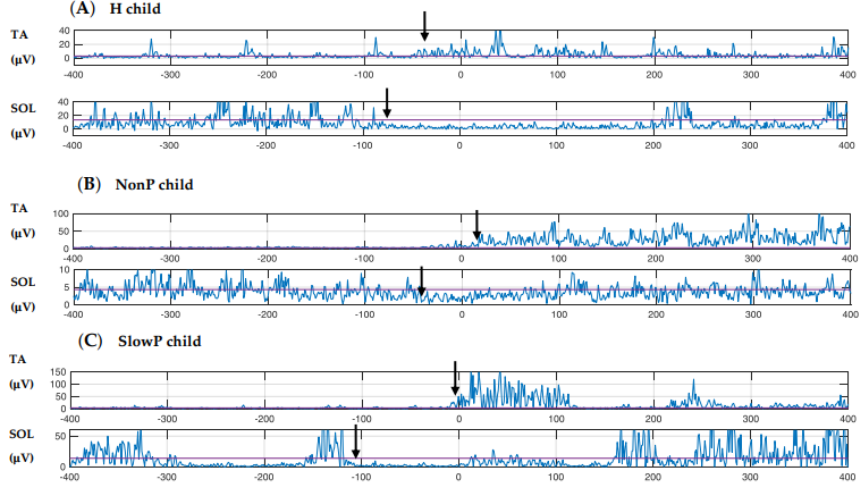
Figure 2. EMG (electromyographic) of shank muscles of the stance leg. Comparison among healthy children H, panel ( A ), children with non-progressive PCA NonP, ( B ) and children with slow progressive PCA SlowP, ( C ). One representative subject for each group. Time 0: APA (anticipatory postural adjustment) onset, defined as the first backward shift of the CoP (center of pressure). Black arrows show SOL (soleus) inhibition and the following TA (tibialis anterior) excitation. Note that the time delay between these two reciprocal actions gradually increased in children with NonP and SlowP with respect to H children.